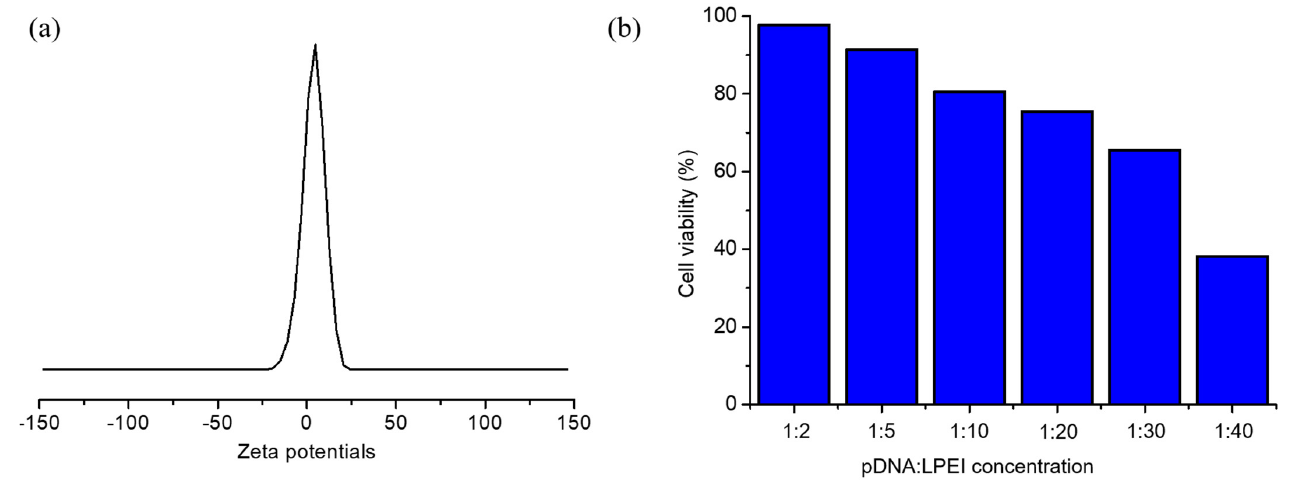
Figure 6. ( a ) Zeta potential result of pDNA-LPEI LTU NPs with a 1:5 ratio of pDNA:LPEI, and ( b ) cell viability of LX2 after X-gal assay transfection investigation using pDNA-LPEI LTU NPs with various LPEI concentrations.